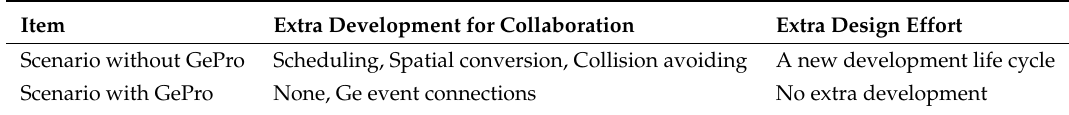
Table 1. Comparison of different programming